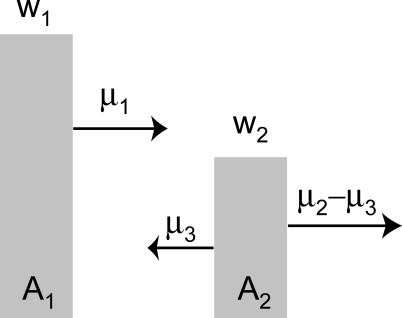
Model of Two Genotypes with Back Mutation, μ3
As in Figure 1, except that some of the mutations away from A
2 recreate genotype A
1. The total mutation rate of A
2 is still μ2, so the back mutation rate cannot exceed this value (i.e., μ3 ≤ μ2).